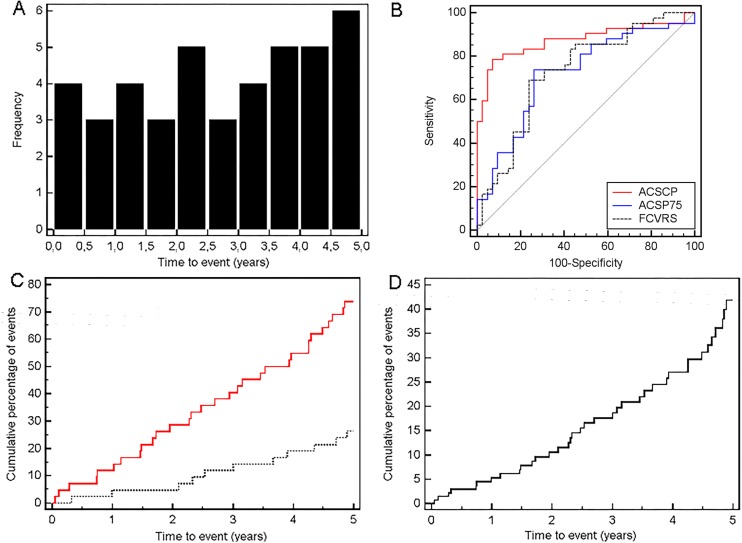
Performance of the ACSP75 urinary polypeptide classifier at follow up.A. Frequency histogram of ACS cases during follow-up. B. Receiver operating characteristic (ROC) curve for the validation set (N = 168). ROC analyses for prediction of ACS using the urinary ACS biomarker pattern ACSP75 (blue solid line), urinary composite classification by ACSCP (red solid line) and Framingham risk score (FCVRS; black spotted line) are shown. C. Kaplan Meier survival curve showing the cumulative percentage with an ACS event based on an ACSP75 score above (red solid line) and below (black spotted line) the threshold of 0.041. D. Multi-variable adjusted Cox proportional-hazards regression analysis of the same data sets based on ACSP75 score above and below the threshold of 0.041.